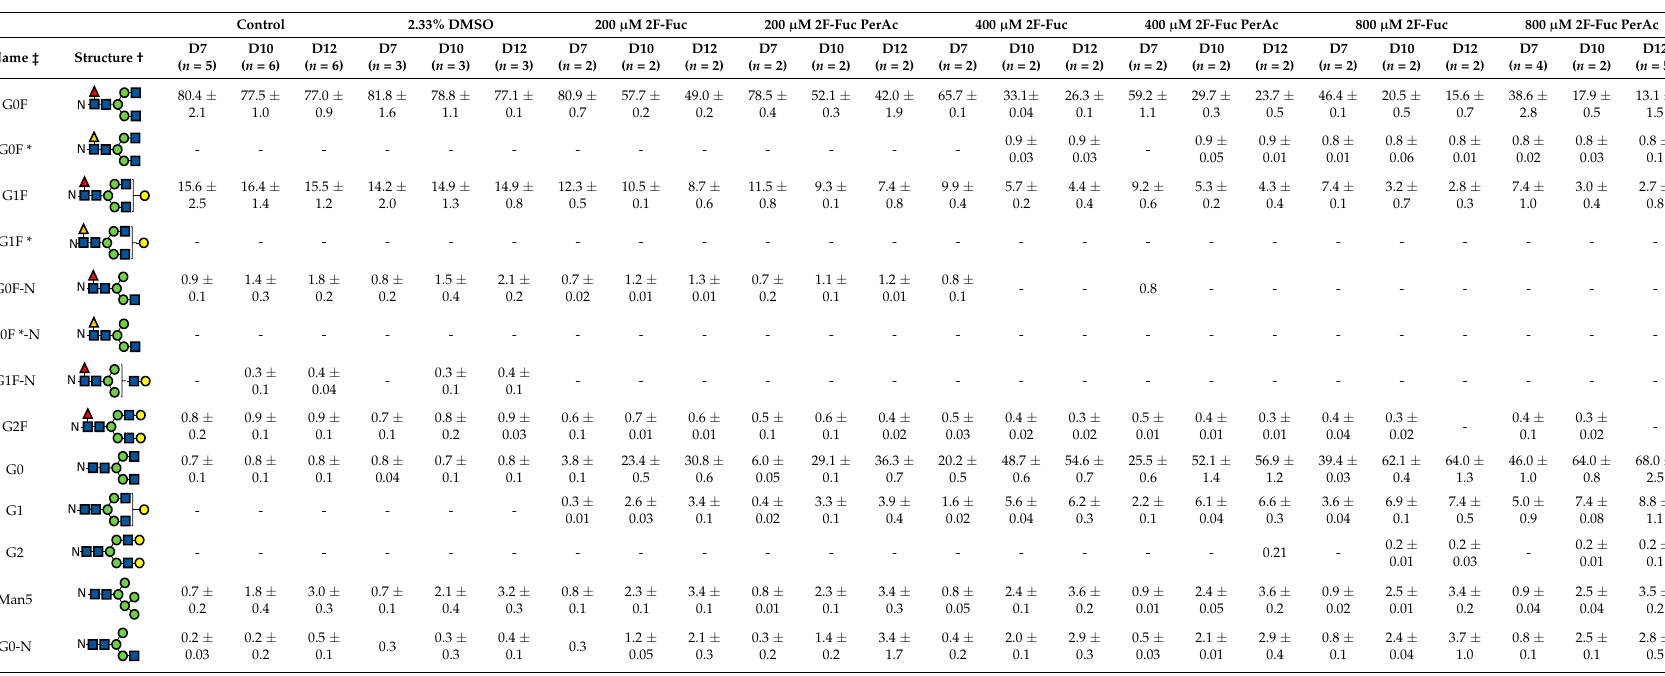
represents N -acetylglucosamine (GlcNAc); represents mannose; represents fucose; represents fucose analogues; represents galactose. ‡ respective fucose-analogue is indicated with *. The Glycan species were identified through the mass. The percentages of various glycans were calculated according to the relative area of each glycan species as detected using RapiFluor™ (Waters) as labelling reagent. Data are presented as mean values ± SEM and without SEM means that the peaks were only detected in one replicate.